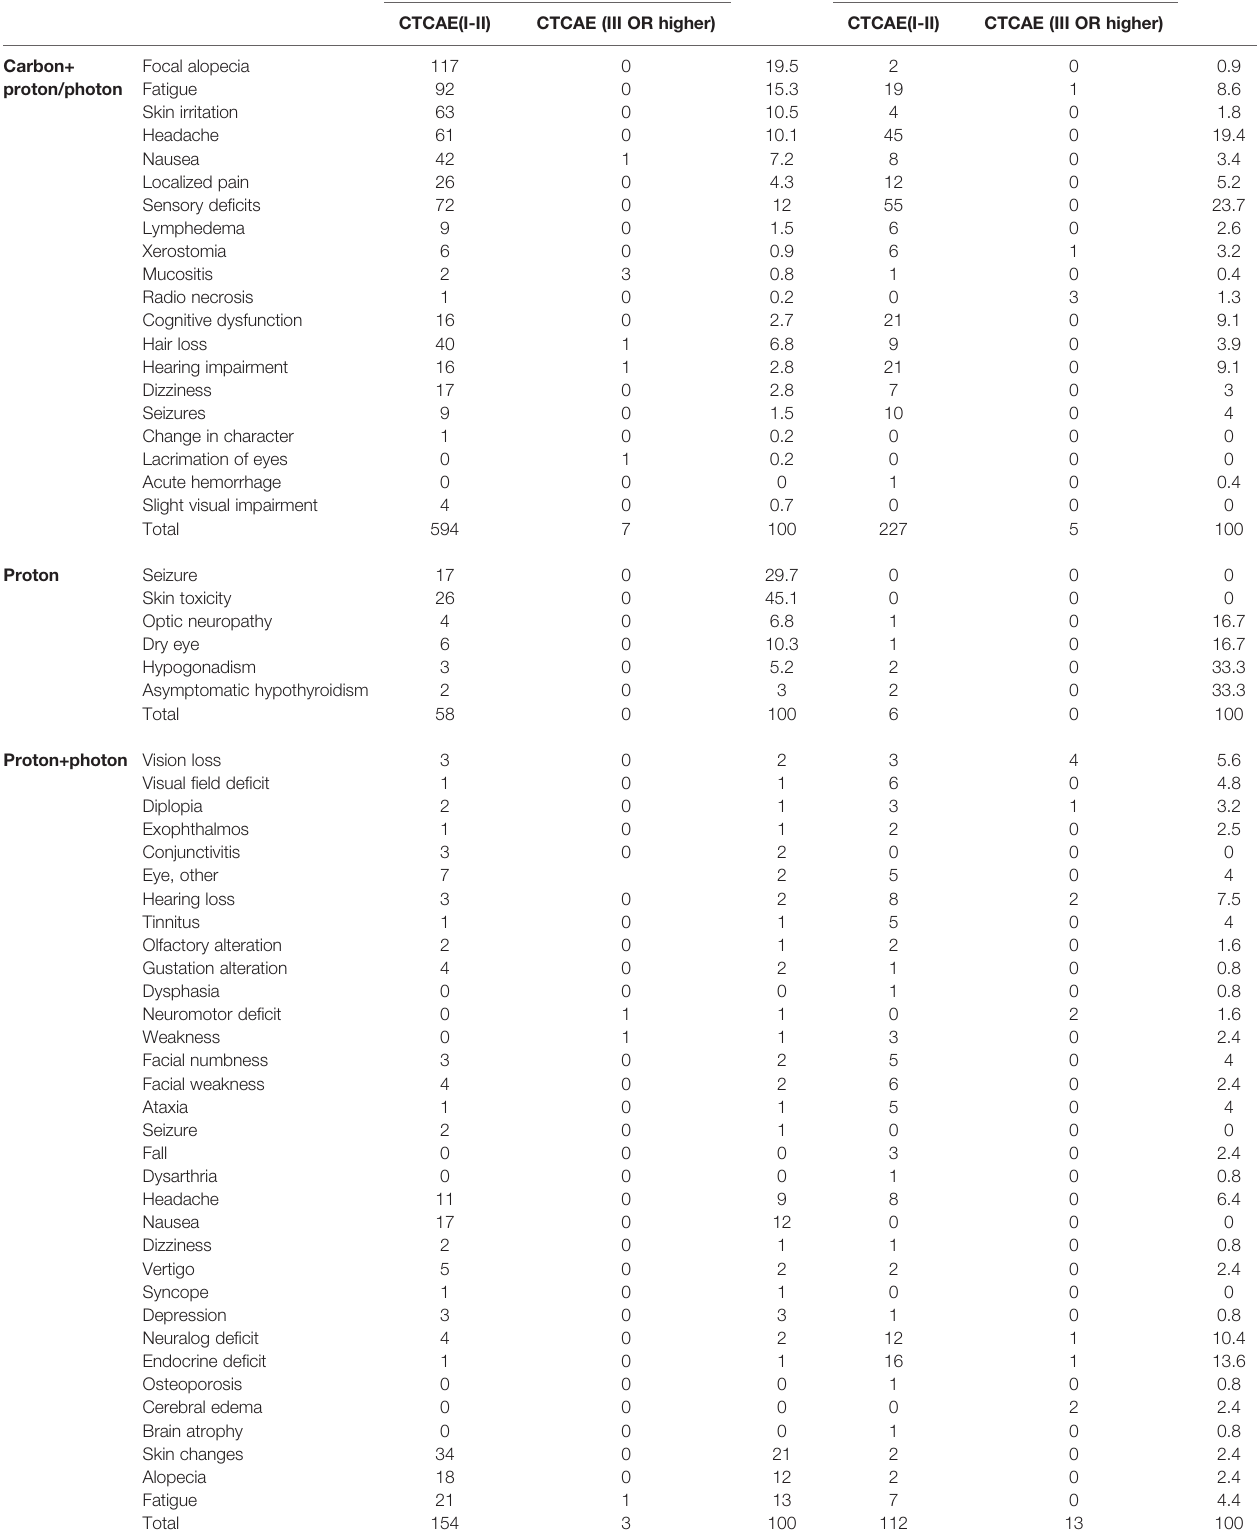
TABLE 3 | Acute and late treatment-related toxicity.